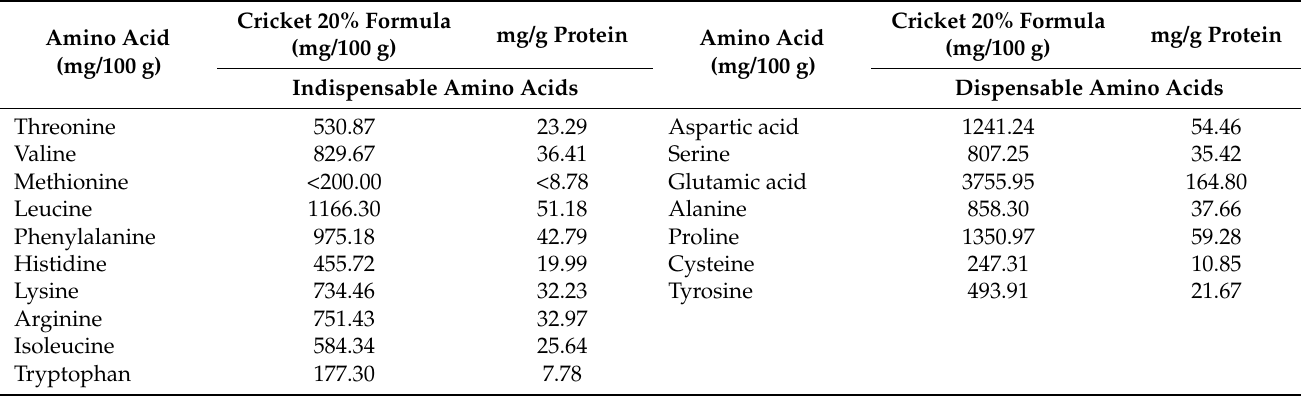
Table 3. Amino acid compositions (mg/100 g dry basis) of the enriched whole wheat bread with 20% cricket powder (the highest